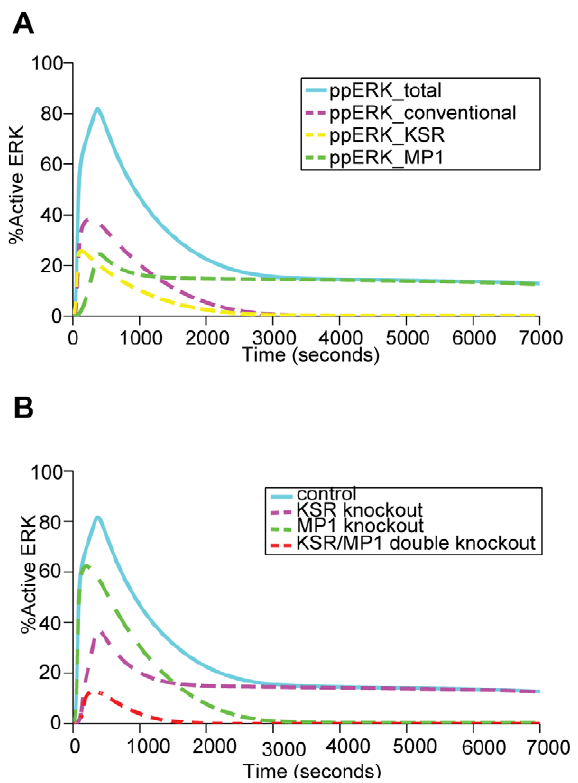
Figure 7. The collective effect of scaffold proteins KSR and MP1 on ERK activation. (A) Overall signaling and contribution from individual modules. (B) Signaling profile under knockout conditions.